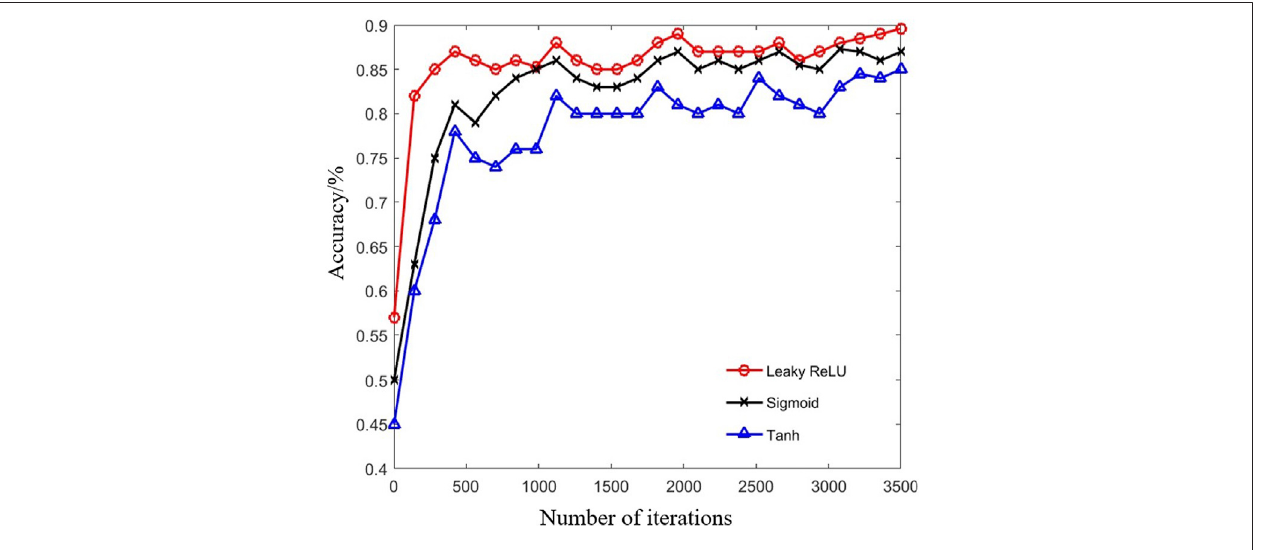
FIGURE 10 | Recognition accuracy under different.